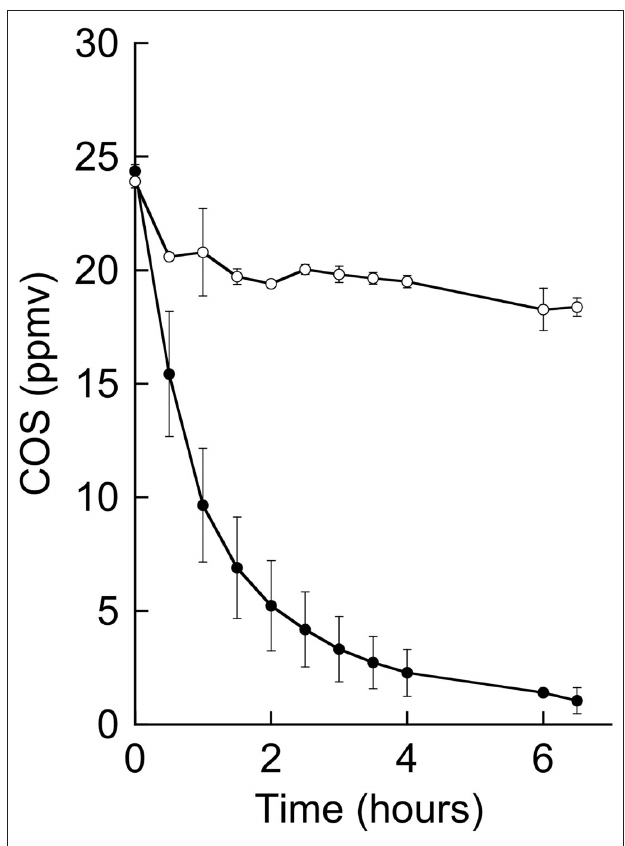
FiguRe 5 | Degradation of 25 ppmv of COS by strain THi503. Cells were suspended in PB. Error bars indicate SD, n = 3. Symbols: Filled circles, + THI 503; empty circles,